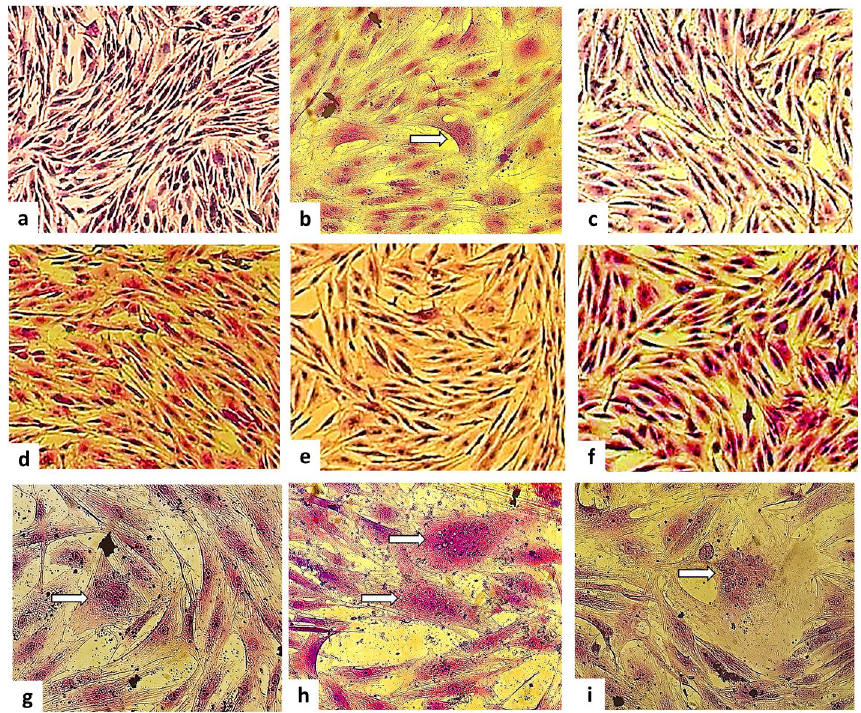
Figure 3. Co-culture with ovine third eyelid cells (OTE) and somatic cells from colostrum infected with CAEV CO (SCC+) treated with Azadirachta indica and Melia azedarach leaf extracts for 90 min after 63 days of culture. ( a ) Negative culture control with OTE cells (×100 magnification). ( b ) Co-culture of OTE and SC C + cells submitted to CEE -AI treatment , with syncytia (arrows) (×100 magnification). ( c ) Co-culture of OTE and SCC+ cells subjected to EAF-AI treatment (×100 magnification). ( d ) Co-culture of OTE and SC C + cells subjected to MF-AI treatment (×100 magnification). ( e ) Co-culture of OTE and SC C + cells submitted to CEE-MA treatment (×100 magnification). ( f ) Co-culture of OTE and SCC+ cells subjected to EAF-MA treatment (×100 magnification). ( g ) Co-culture of OTE and SCC+ cells subjected to MF-MA treatment (×200 magnification). ( h ) Co-culture of OTE and SC C + with syncytia (arrows) (control treatment without extract) (×200 magnification). ( i ) Positive control of CAEV CO -infected OTE cells with syncytia (arrows) (×200 magnification). CEE-AI: crude ethanolic extract— Azadirachta indica ; EAF-AI: ethyl acetate fraction— Azadirachta indica ; MF-AI: fraction methanol Azadirachta indica ; CEE-MA: crude ethanolic extract— Melia azedarach ; EAF-MA: ethyl acetate fraction— Melia azedarach ; MF-MA: fraction methanol— Melia